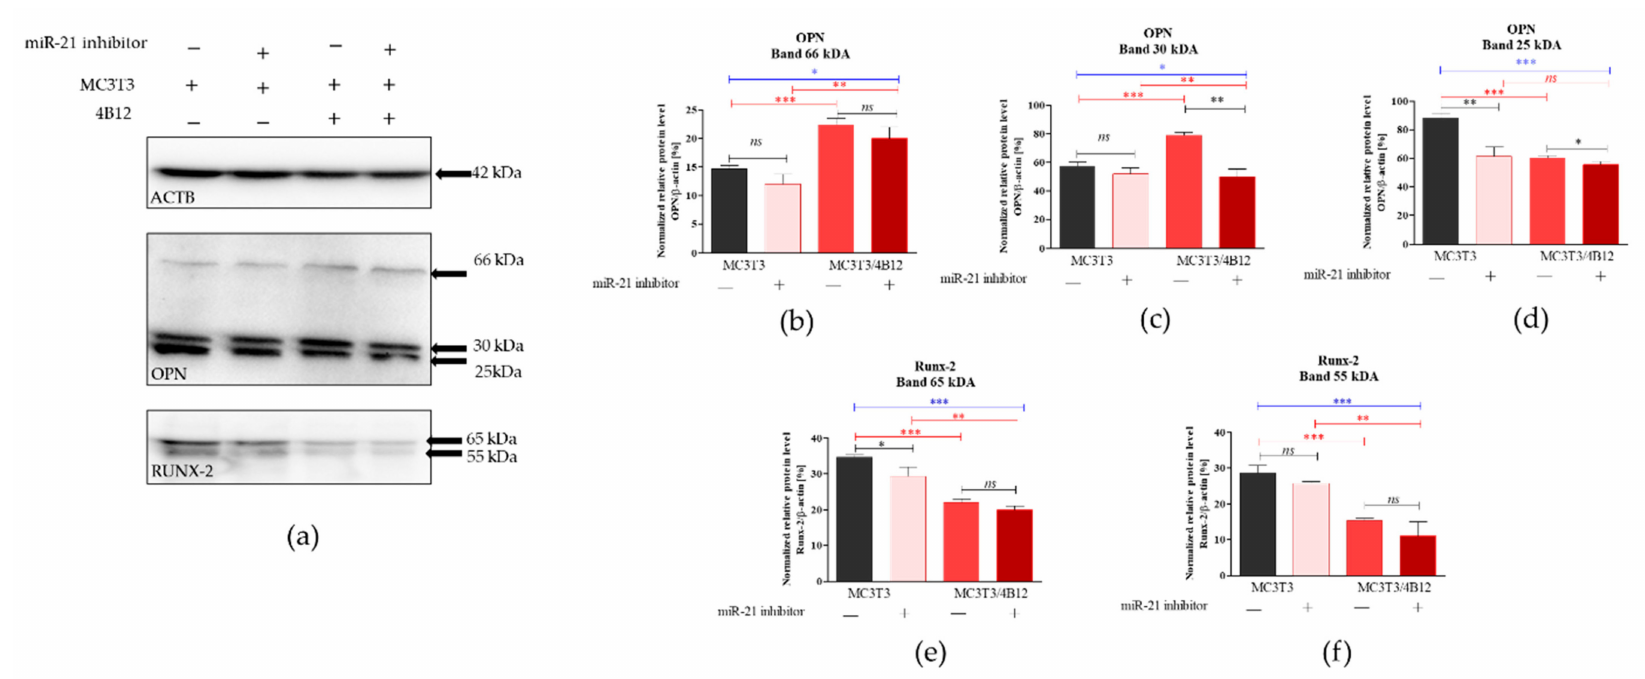
Figure 5. Intracellular accumulation of osteopontin (OPN) and runt-related transcription factor 2 ( Runx-2 ). The β -actin (ACTB) was used as a housekeeping protein for normalization. The representative blots are shown in graph ( a ) and molecular weights of the detected proteins are indicated on the right. Results of statistical analysis performed on normalized values are shown in graphs ( b – f ). Significant di ff erences are indicated with asterisks (* p < 0.05; ** p < 0.01 and *** p < 0.001), while non-significant di ff erences are marked as ns . The comparisons between groups are marked with square